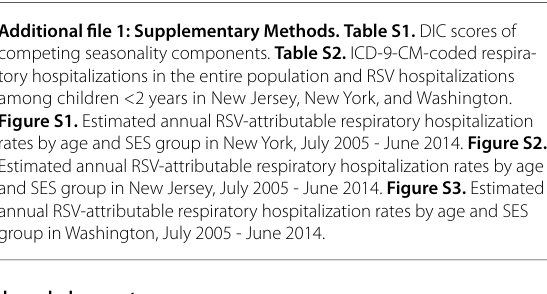
Figure S1. Estimated annual RSV-attributable respiratory hospitalization rates by age and SES group in New York, July 2005 - June 2014. Figure